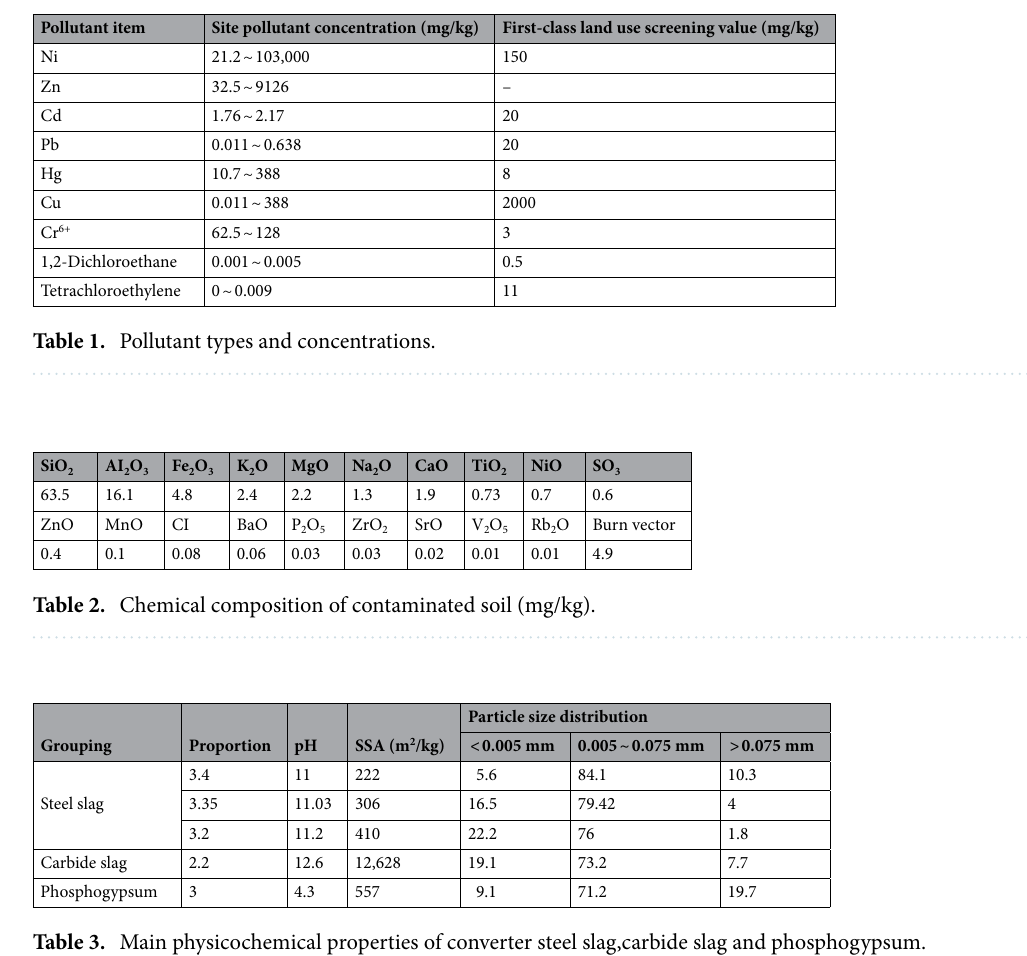
Table 3. Main physicochemical properties of converter steel slag,carbide slag and phosphogypsum.